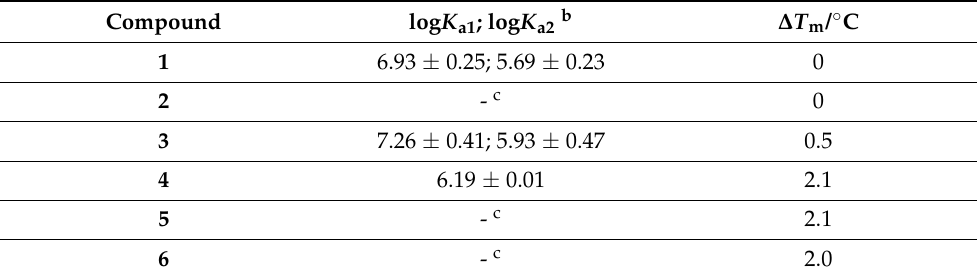
Table 2. Binding constants (log K a ) a for 1:1 and 1:1/1:2 complexes of 1–6 -Tel22 calculated from the fluorescence titrations and ∆ T m d values ( ◦ C) of Tel22 upon addition of ratio e r = 1.0 of 1–6 (sodium